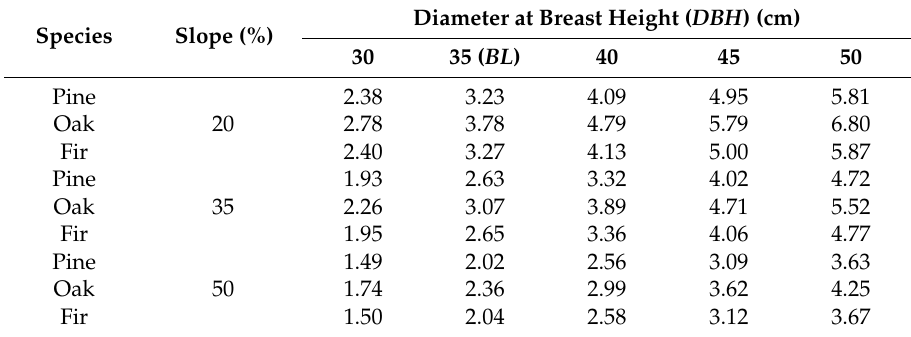
Table 4. Productivities for manual felling using chainsaw according to species, slope class, Diameter at Breast Height ( DBH ) and D factor (m 3